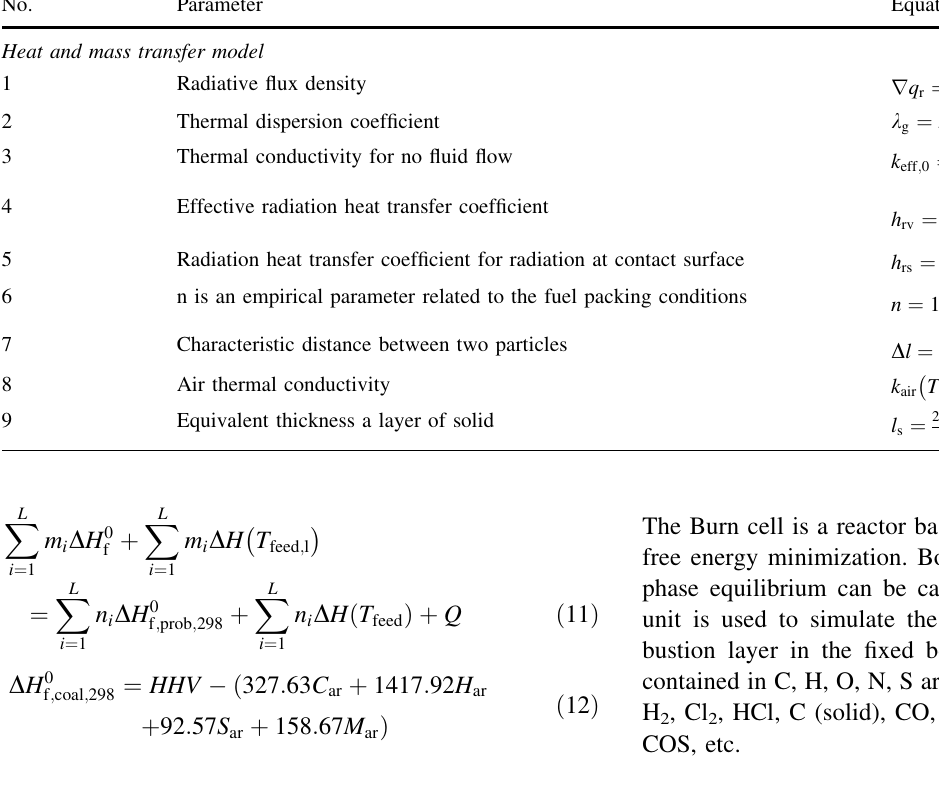
Table 9 Interphase heat transfer